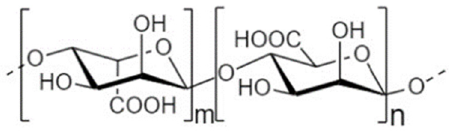
Figure 5. AOS structure: the main components of AOS are 1,4-linked β - D -mannuronic acid and 1,4-linked α - L -guluronic acid. AOS, alginate-oligosaccharides.